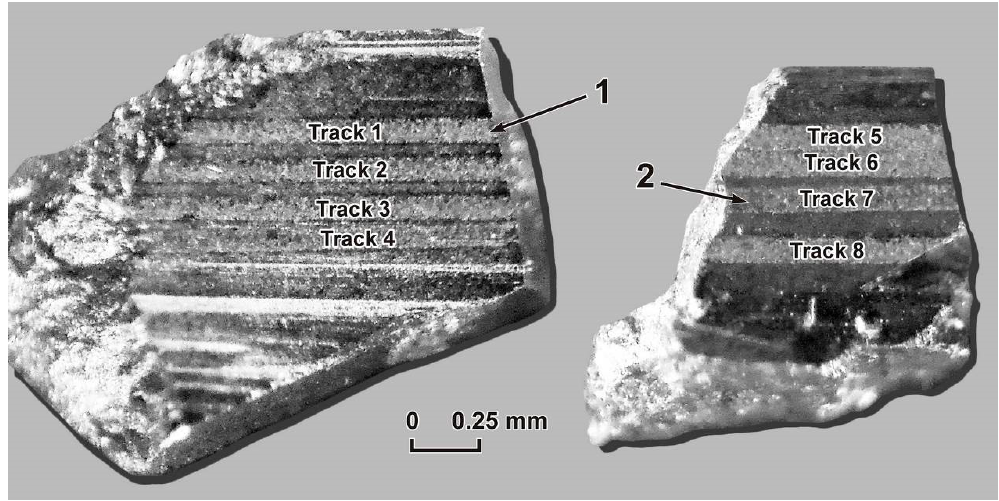
Figure 12. Arsenopyrite Crystals 1 and 2 (sample UV-3/13) from ores of the Natalkinskoe deposit. Tracks 1–9, numbers of laser passes over the crystal surface. The results of LA-ICP-MS analysis are presented in Table 12.